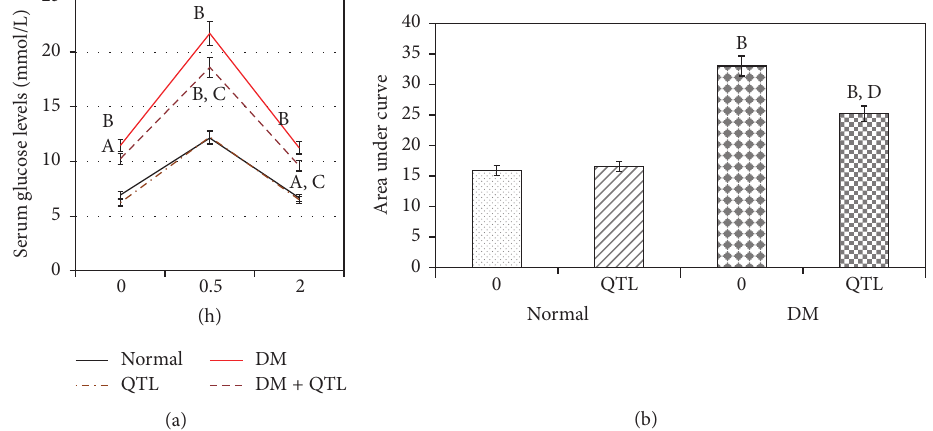
Figure 1: Effects of QTL on oral glucose tolerance (a) and AUC (b) in normal and diabetic mice . Data represent the mean ± SD from ten animals in each group. A 𝑃 < 0.05 compared to control group; B 𝑃 < 0.01 compared to control group; C 𝑃 < 0.05 compared to diabetic group; D 𝑃 < 0.01 compared to diabetic group.